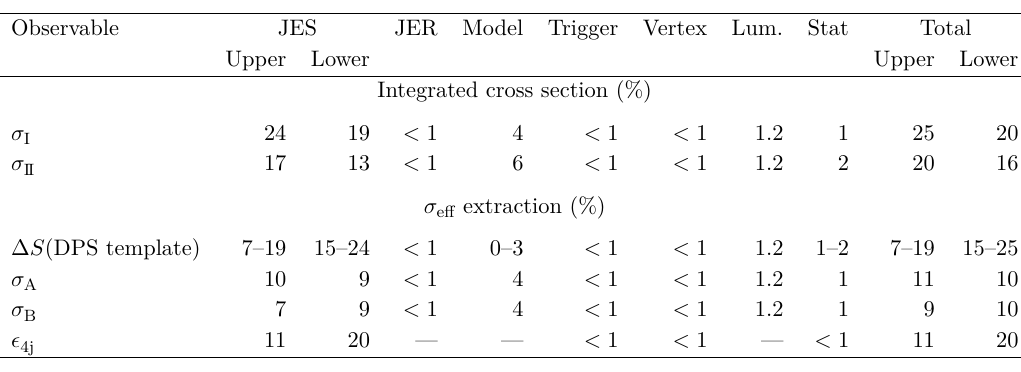
Table 2 . Systematic uncertainties, along with the statistical and the total uncertainties for the cross sections of the two phase space regions, along with the observables needed for the extraction of σ DPS , in percent. The JES uncertainty leads to asymmetric uncertainties (an upper and a lower A , B error): all other systematic uncertainties, as well as the statistical uncertainty, are symmetric.